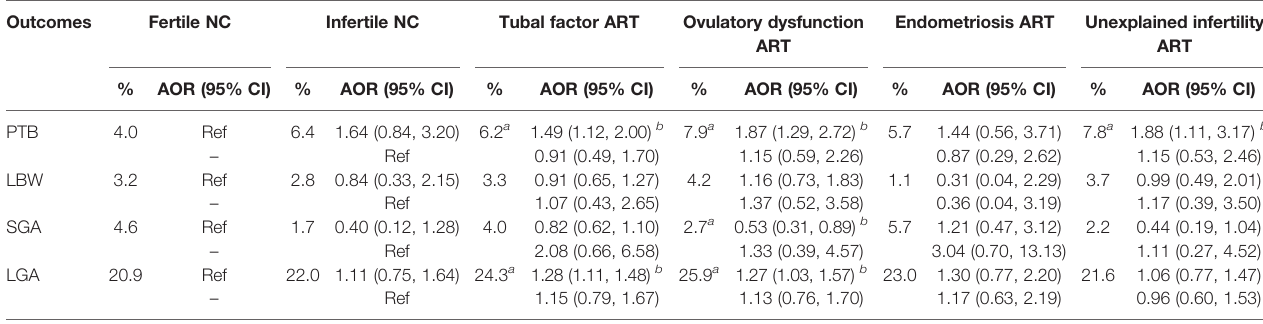
TABLE 3 | Risks of adverse perinatal outcomes within different causes of infertility. Outcomes Fertile NC Infertile